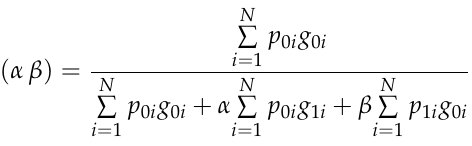
Figure 7. The accuracy and error plots of the proposed customized CNN model. ( a ) R O C p l o t